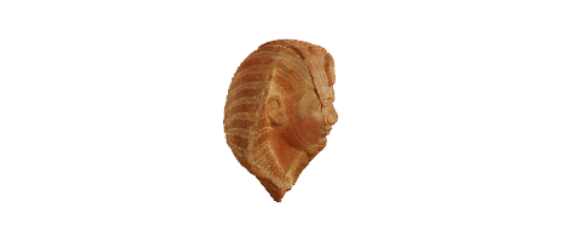
Figure 1. 3D model of pharaoh head (Allard Pierson Museum)